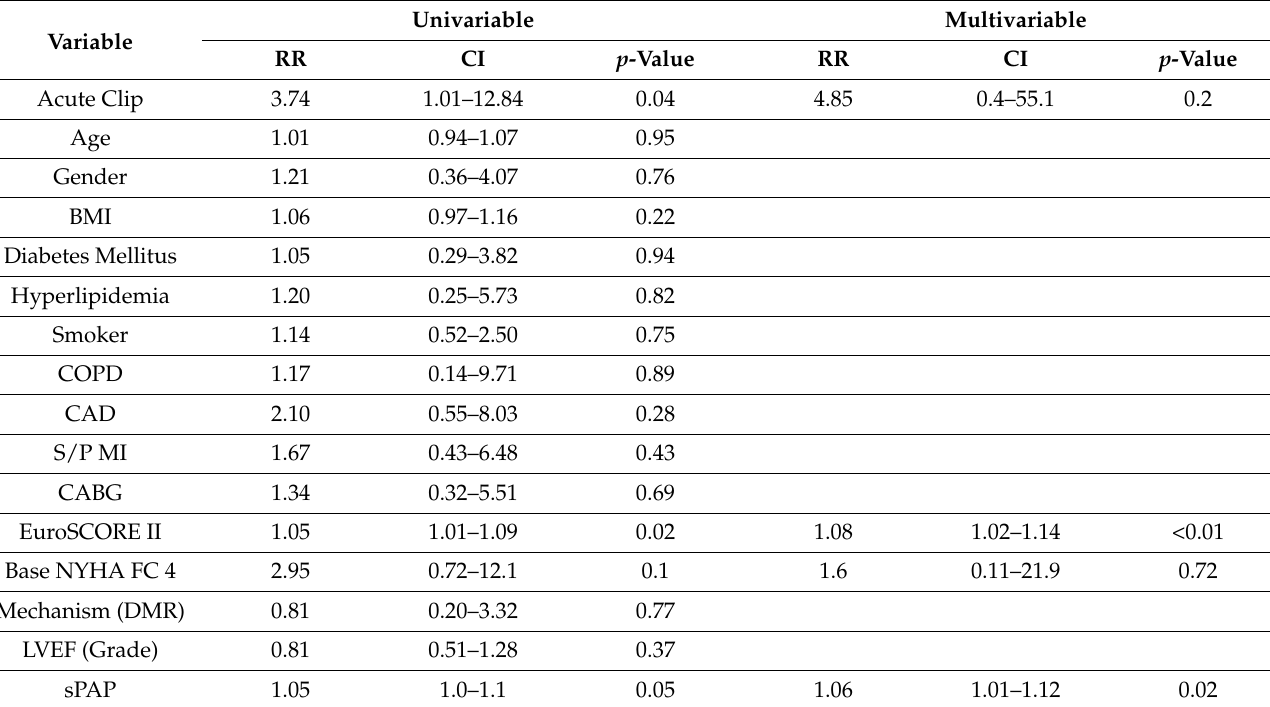
Table 7. Logistic regression analysis for prediction of cardiovascular mortality during 30-day follow-up after PMVr.